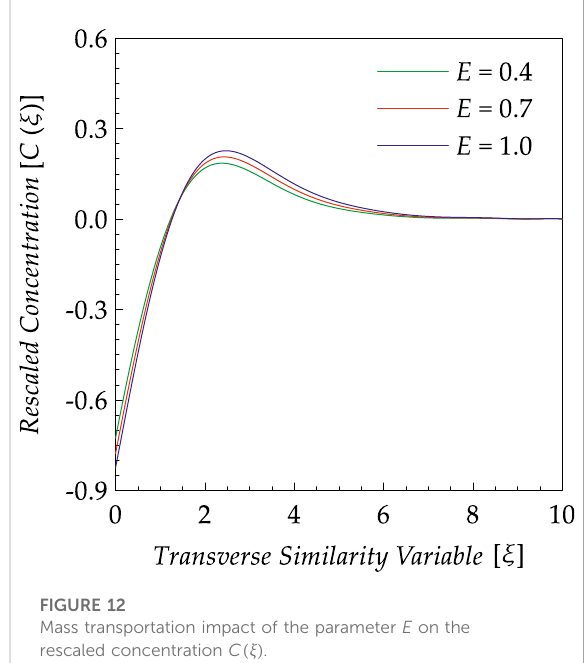
rescaled concentration C ( ξ ) .